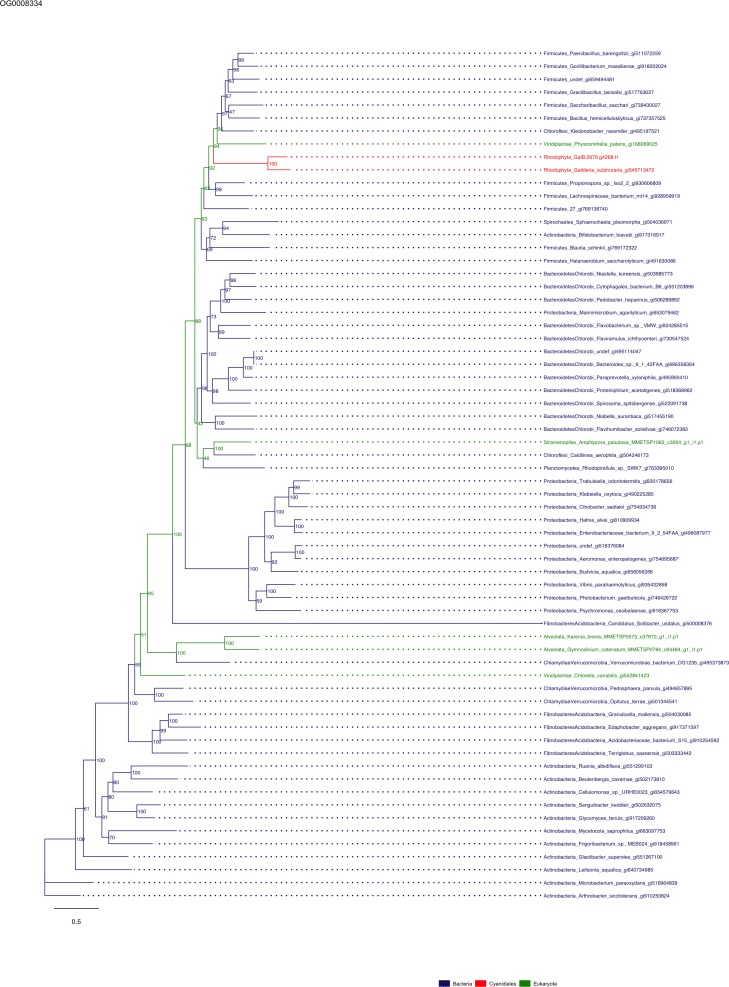
Sequence tree of orthogroup OG0008334.The tree is based on amino acid sequences. Archaea (yellow), Bacteria (blue), Cyanidiales (red), Eukaryotes including other red algae (green). Branches containing Cyanidiales sequences are highlited in red.